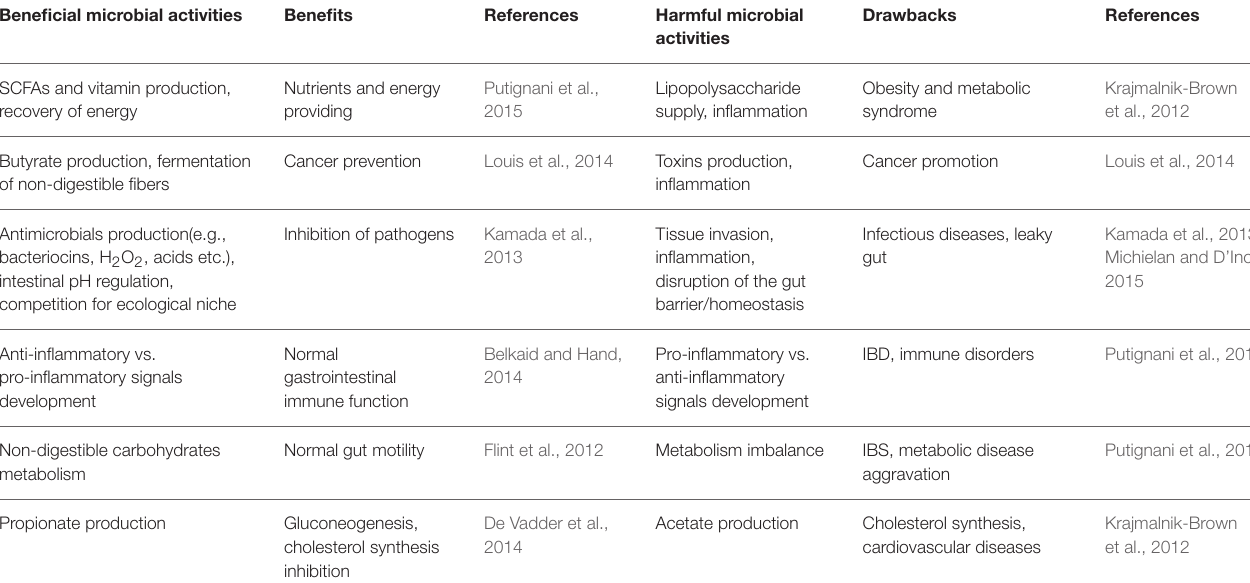
TABLE 1 | Role of gut microbiota metabolites on health and